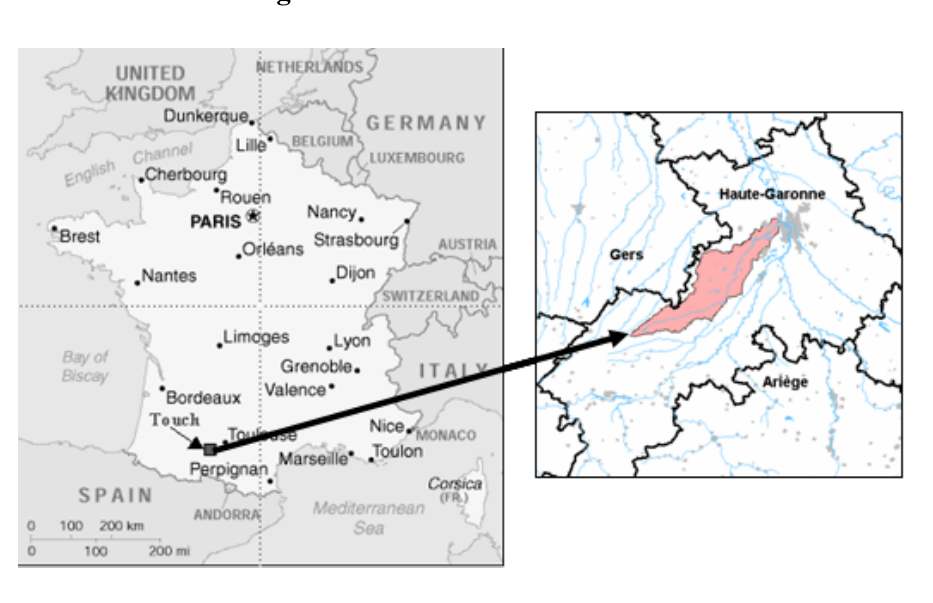
Figure 1. Location of Touch